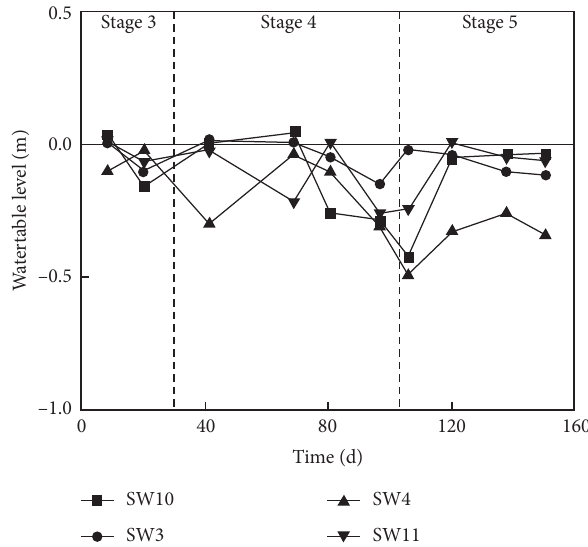
Figure 12: Variation of groundwater table levels during excavation.